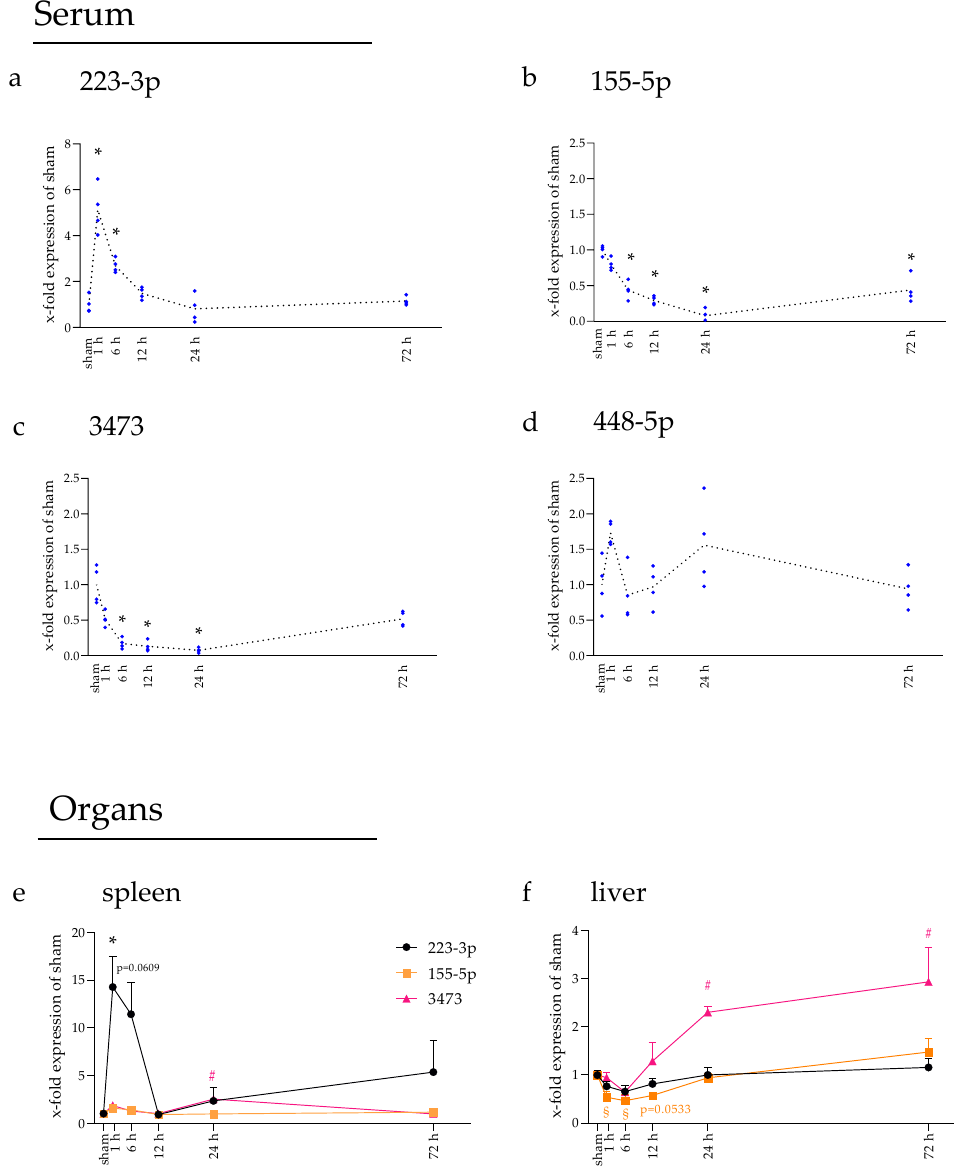
Figure 4. miRNA expression in blood serum and distant organs. ( a ) miRNA levels in serum for miR-223-3p, ( b ) miR-155-5p, ( c ) miR-3473, and ( d ) miR-448-5p. Individual values are pictured in the graphs. (*) shows a statistical significance between the expression at the specific time point and sham ipsi. (black) miRNA expression for miR-223-3p, (yellow) miR-155-5p, and (pink) miR-3473 in ( e ) the spleen and ( f ) liver was calculated separately but is shown in a combined graph. Note that miR-448-5p was not detectable in distant organs. In ( e , f ), (*) shows a significant difference for miR-223-3p, (§) for miR-155-5p, and (#) for miR-3473.